Question: State the chart type depicted above.
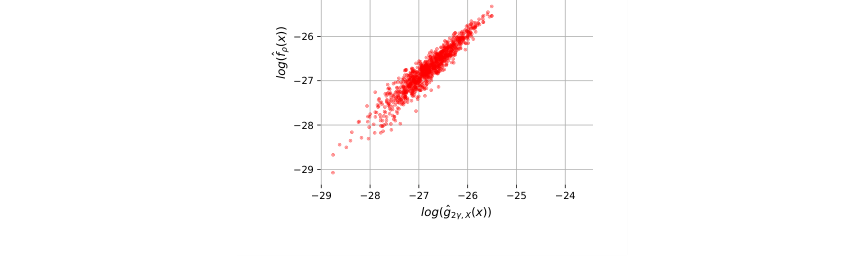
Answer: scatter